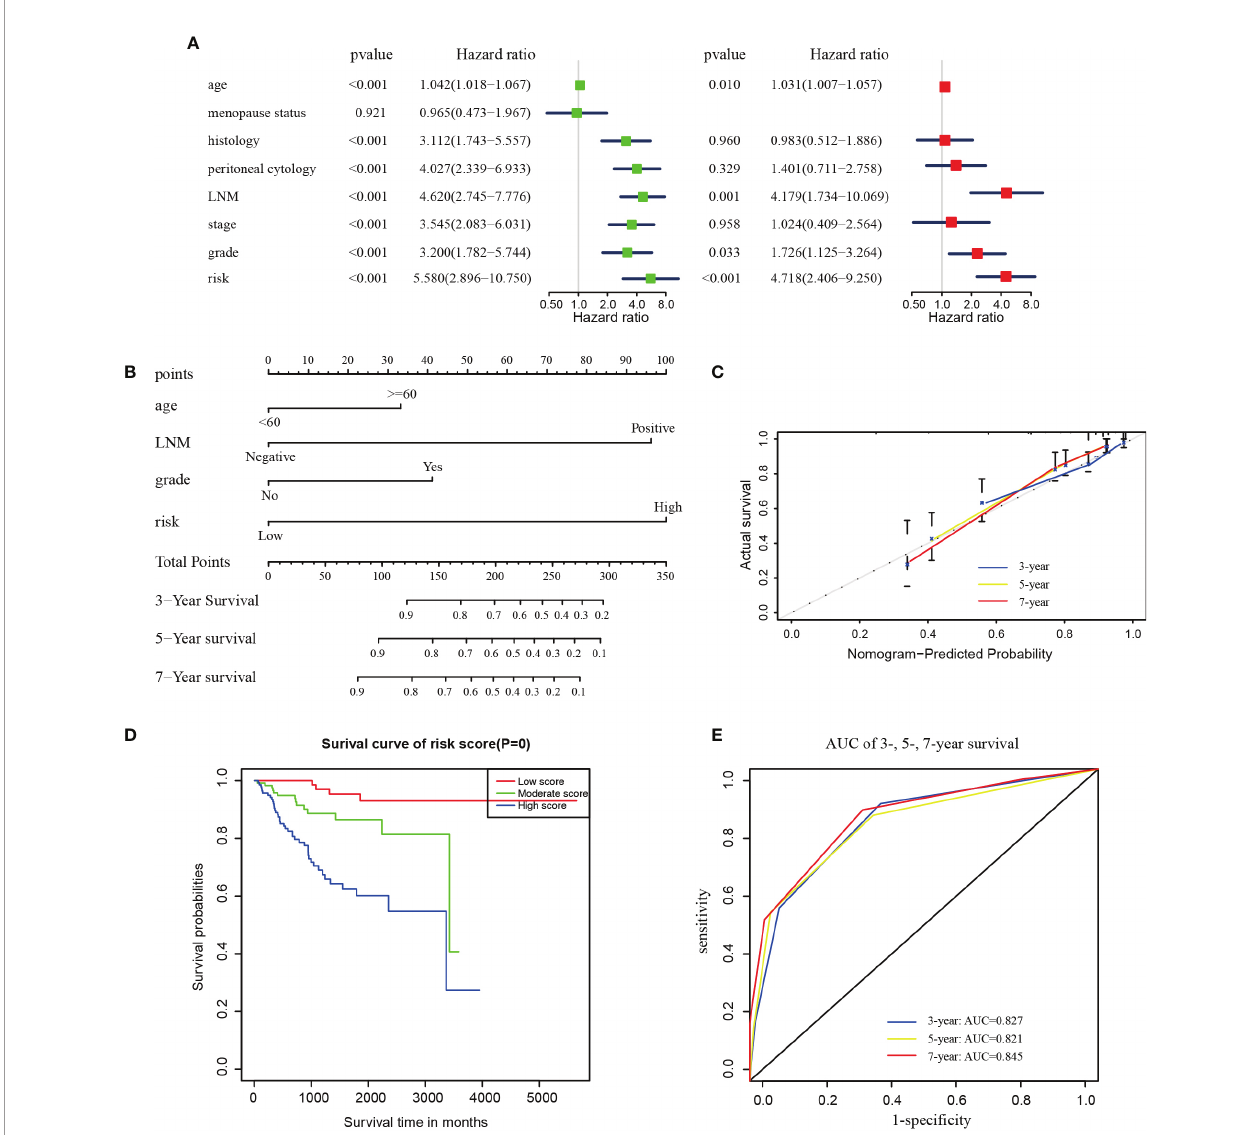
FIGURE 4 | The construction of the predictive nomogram for EC patients from TCGA. (A) Univariate and multivariate Cox regression analyses of the association between clinicopathological factors (including the risk signature) and OS of patients in the TCGA dataset; (B) Nomogram for predicting the probability of 1-, 3-, and 5-year OS for the prognosis of EC patients. Four factors were included in this nomogram. (C) Calibration plot of the nomogram for predicting the probability of OS at 1, 3, and 5 years; (D) Survival curves of the three groups divided by total score of the nomogram. (E) The time ‐ dependent ROC